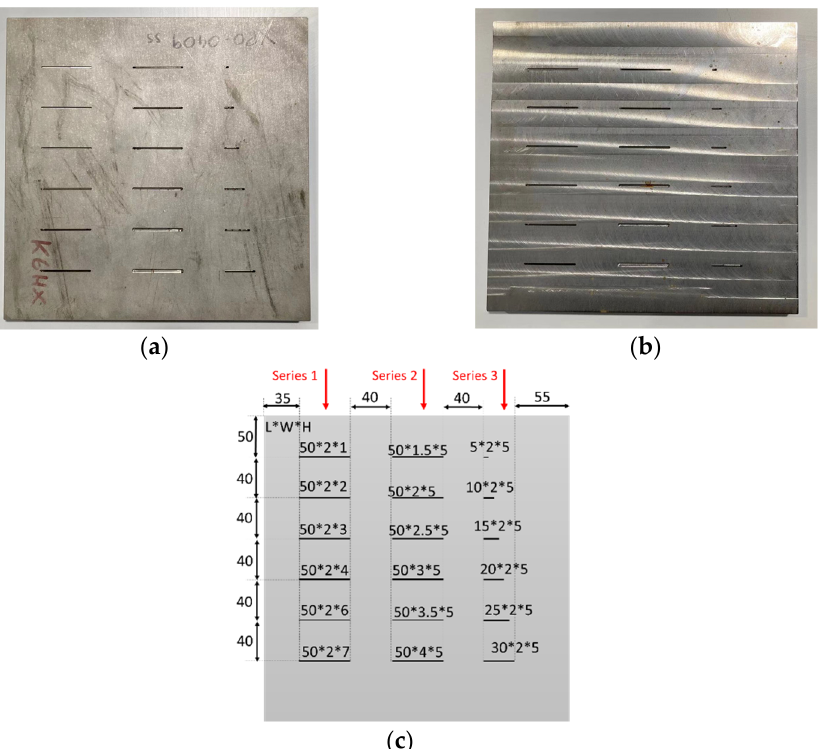
Figure 4. ( a ) Stainless steel; ( b ) carbon steel; and ( c ) crack sample preparation schematic.